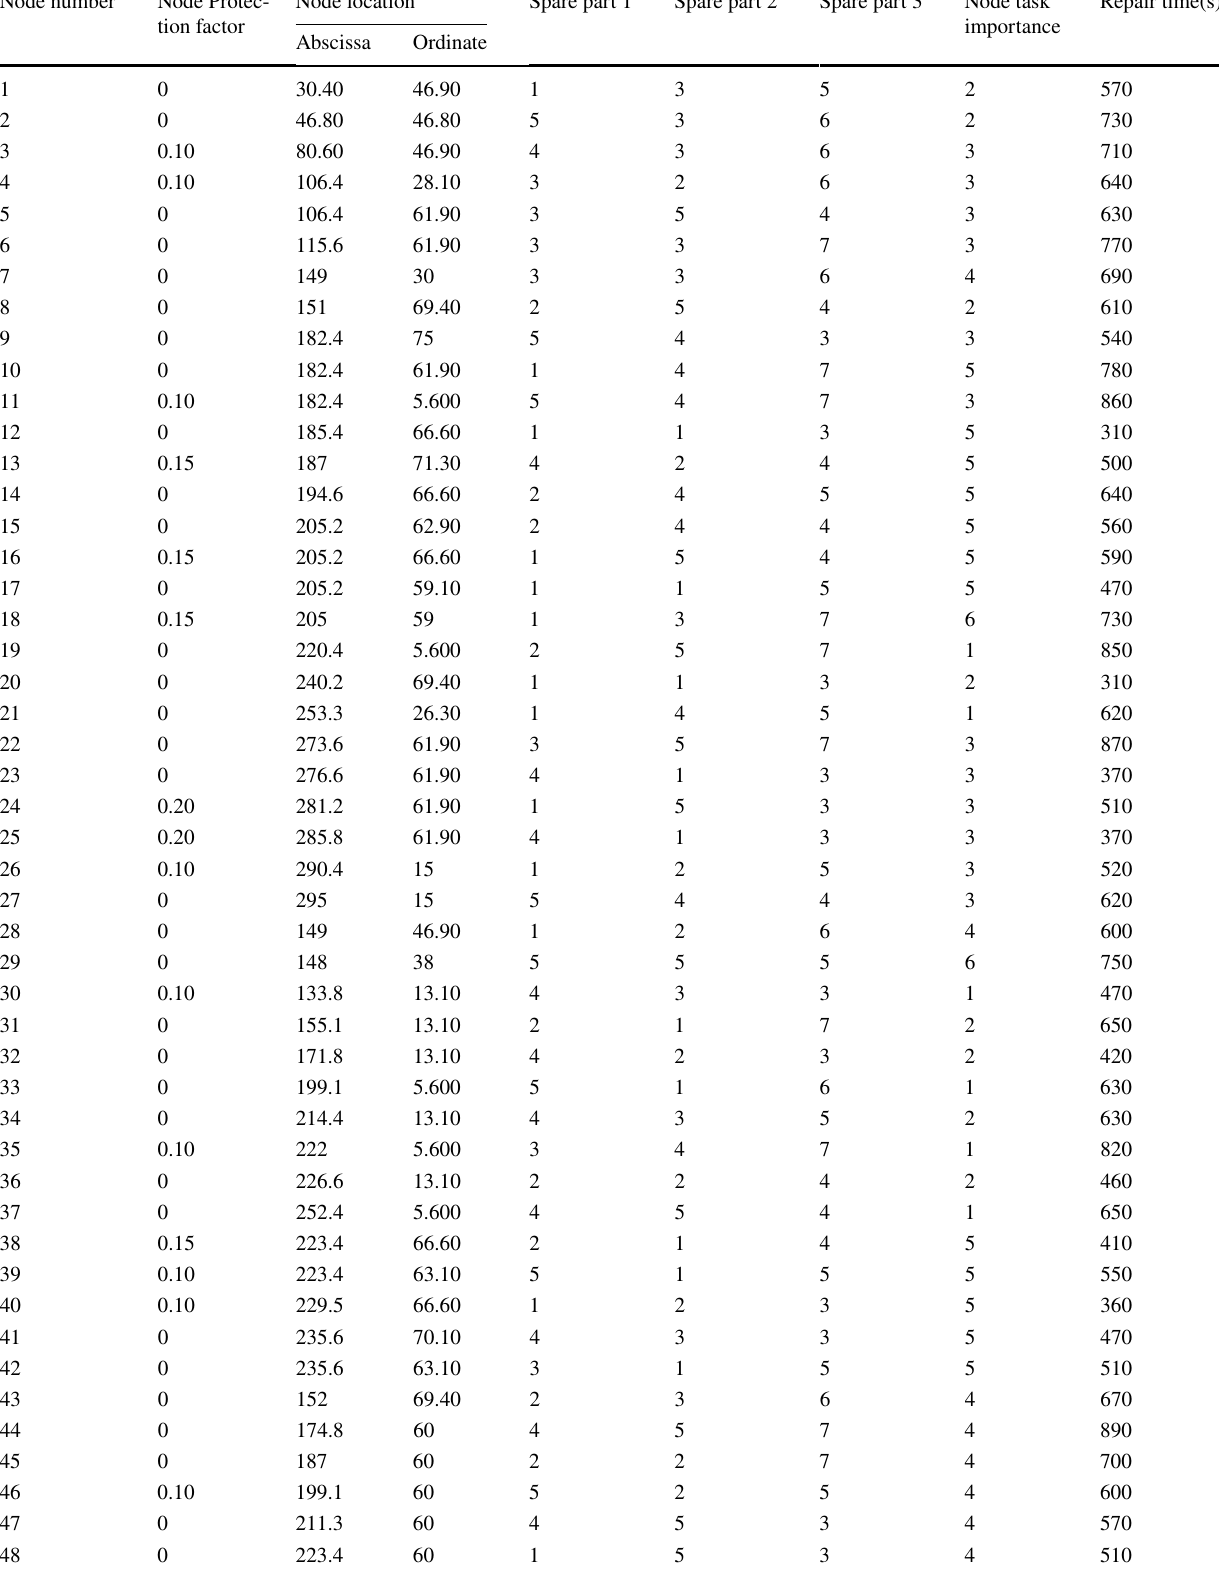
Table 3 Node information of network Node